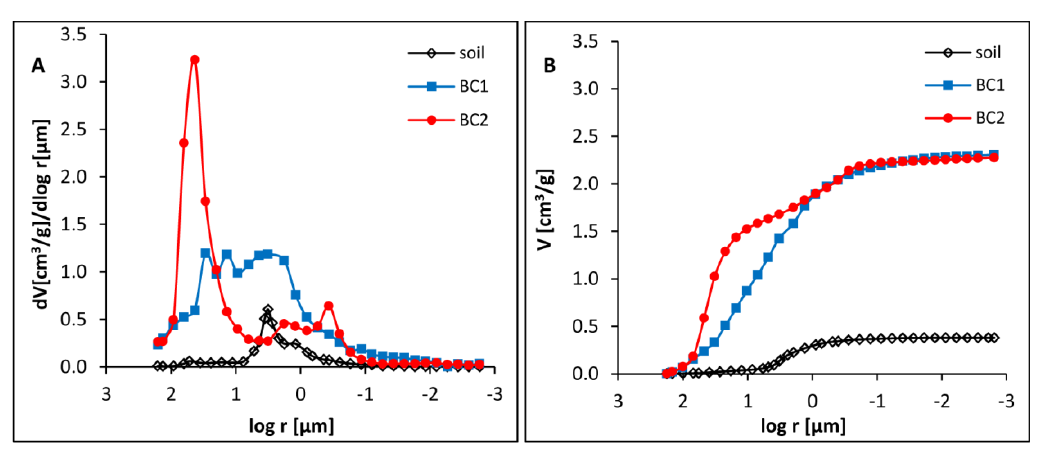
Figure 2. Differential ( A ) and cumulative ( B ) curves of pore volume vs. equivalent pore radius of Dystric Cambisol and biochar used for cylinder preparation; the curves were drawn based on the mean value of three measurements.